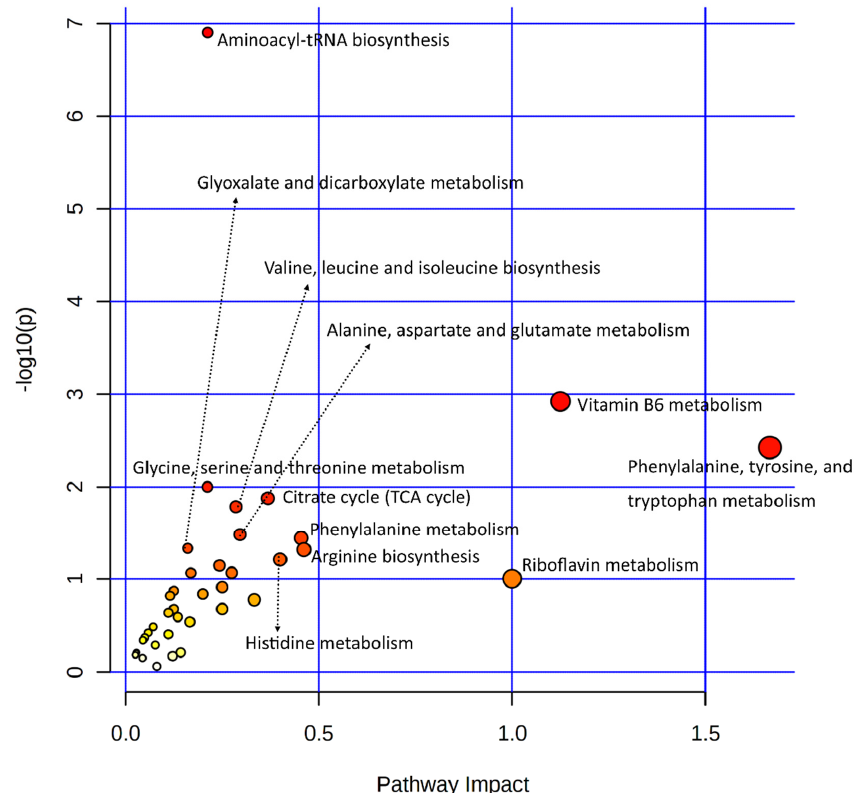
Figure 3. A dot plot illustration of pathway enrichment by significantly differentially expressed metabolites was used in this study. Various pathways within the upper and left quadrants are labeled. The dot sizes increase with the increasing pathway impact; the color intensifies according to the y - axis.